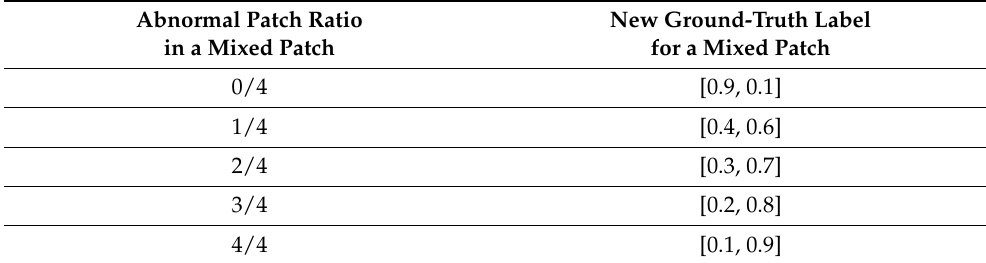
Table 3. Labeling strategy for a mixed